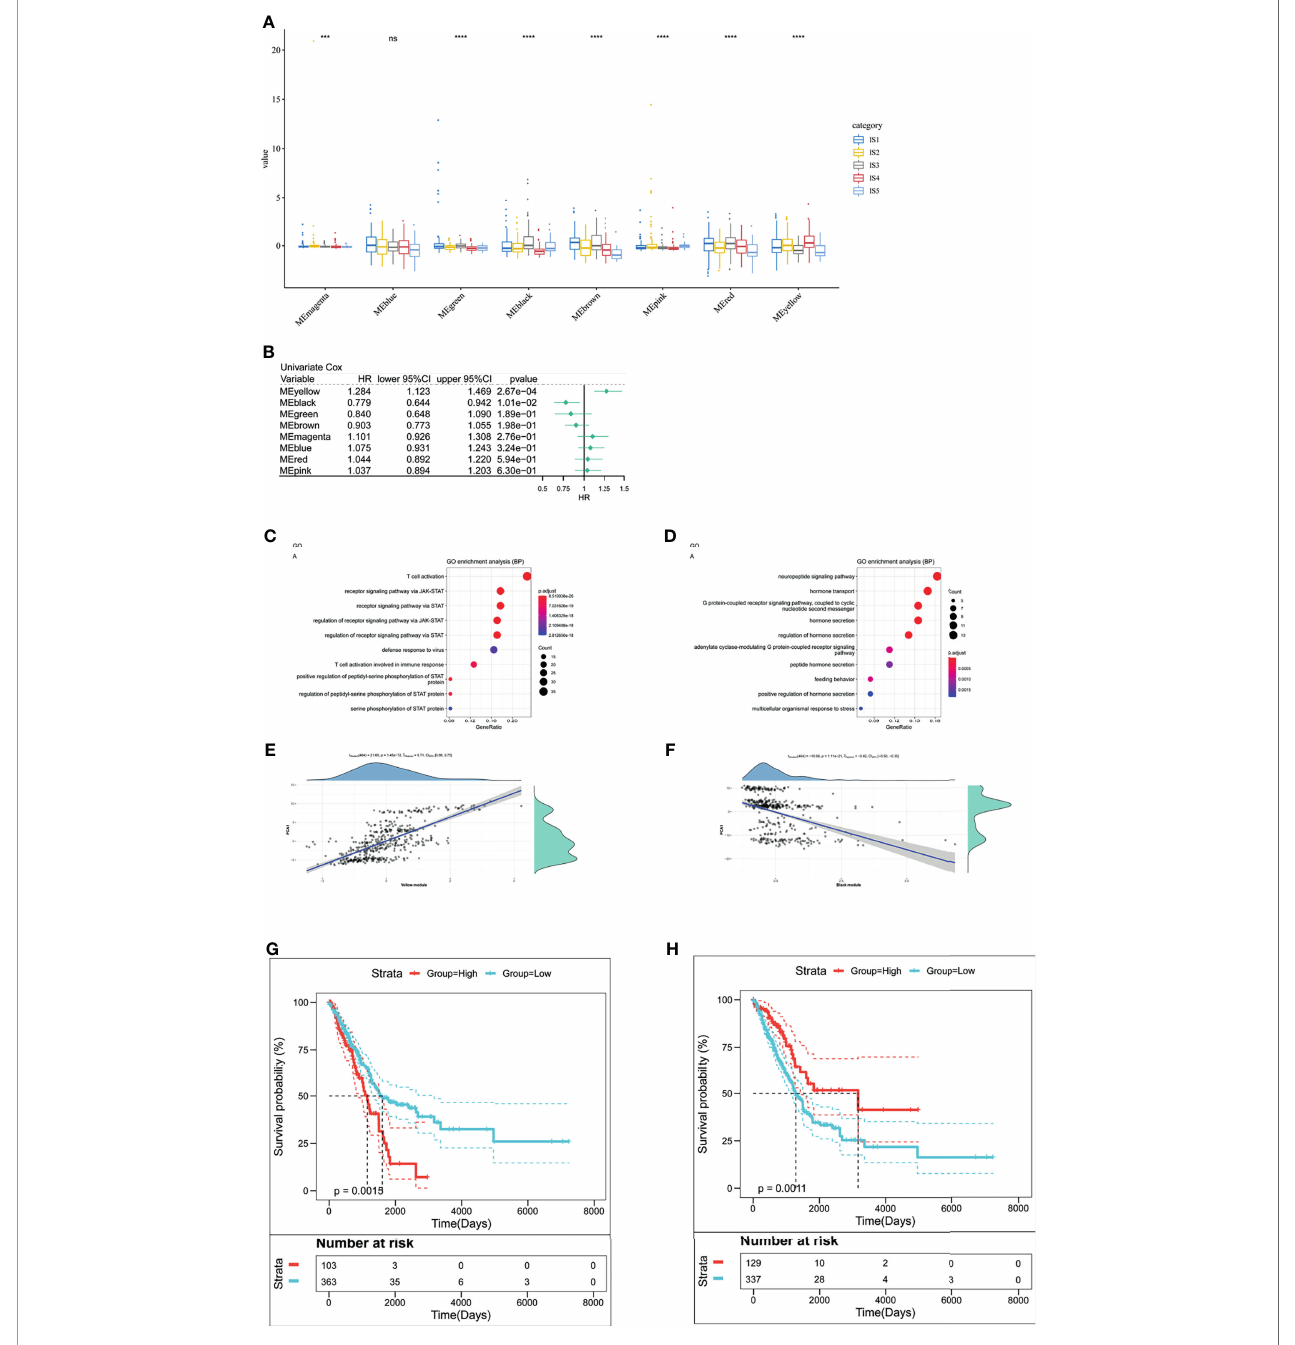
FIGURE 8 | The analysis of LUAD-related hub genes. (A) Differential distribution of fi ve LUAD-related ISs in each module. (B) Forest maps of survival analysis of eight LUAD modules. *** p < 0.001, **** p < 0.001. ns presents no difference. (B, C) Enrichment map of biological processes in the yellow module (C) . The dot size stands for the number of events. The color intensity stands for the enrichment level. The correlation between the yellow module and PCA1 component in immune landscape (D) . (E, F) Enrichment map of biological processes in the black module (E) . The dot size stands for the number of enrichment genes. The color intensity stands for the enrichment level. The correlation between the black module and PCA1 component in immune landscape (F) . (G) Kaplan – Meier curves of the yellow module with low group scores and high group scores. (H) Kaplan – Meier curves of the black module with low group scores and high group